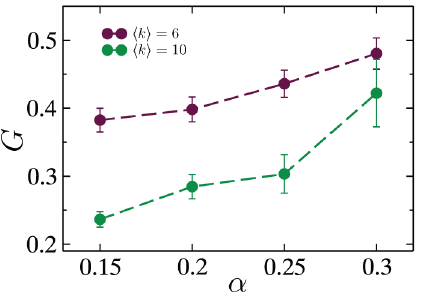
Figure 8. The effect of average degree upon cascading failures. Fraction of the largest surviving network component following cascading failures ( G ) triggered by the removal of a single, randomly chosen node as function of a tolerance parameter. The two curves correspond to two ensembles of random geometric graphs, one with S k T ~ 6 (maroon) and one with S k T ~ 10 (green). Data were obtained for RGGs of size ( N ~ 1500) , averaged over more than 400 network realizations. The error bars correspond to the standard error of the mean.